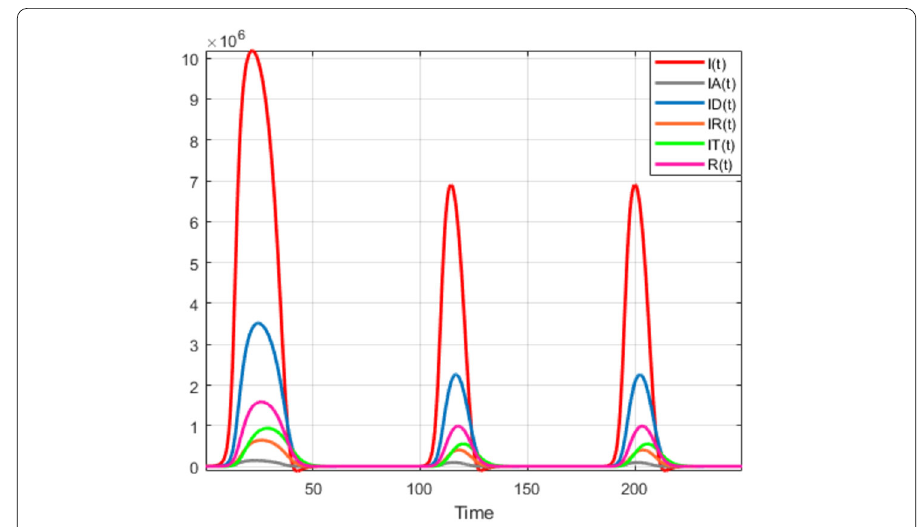
Figure 35 Numerical visualization of COVID-19 model for α = 1